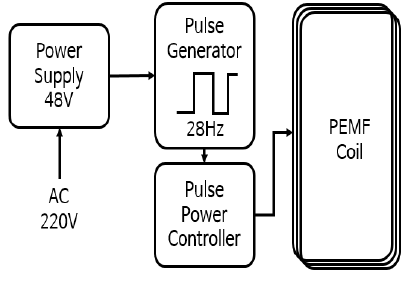
Figure 1. Diagram of the PEMF device.